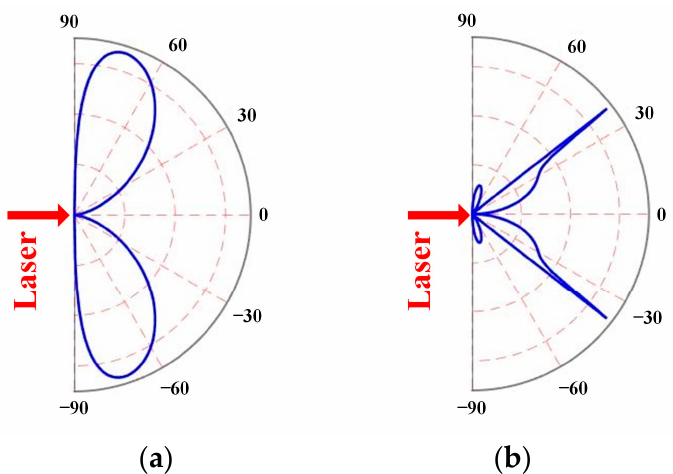
Figure 1. Directivity patterns of laser-generated ultrasonic waves in iron: ( a ) longitudinal wave and ( b ) shear wave in thermoelastic regime.